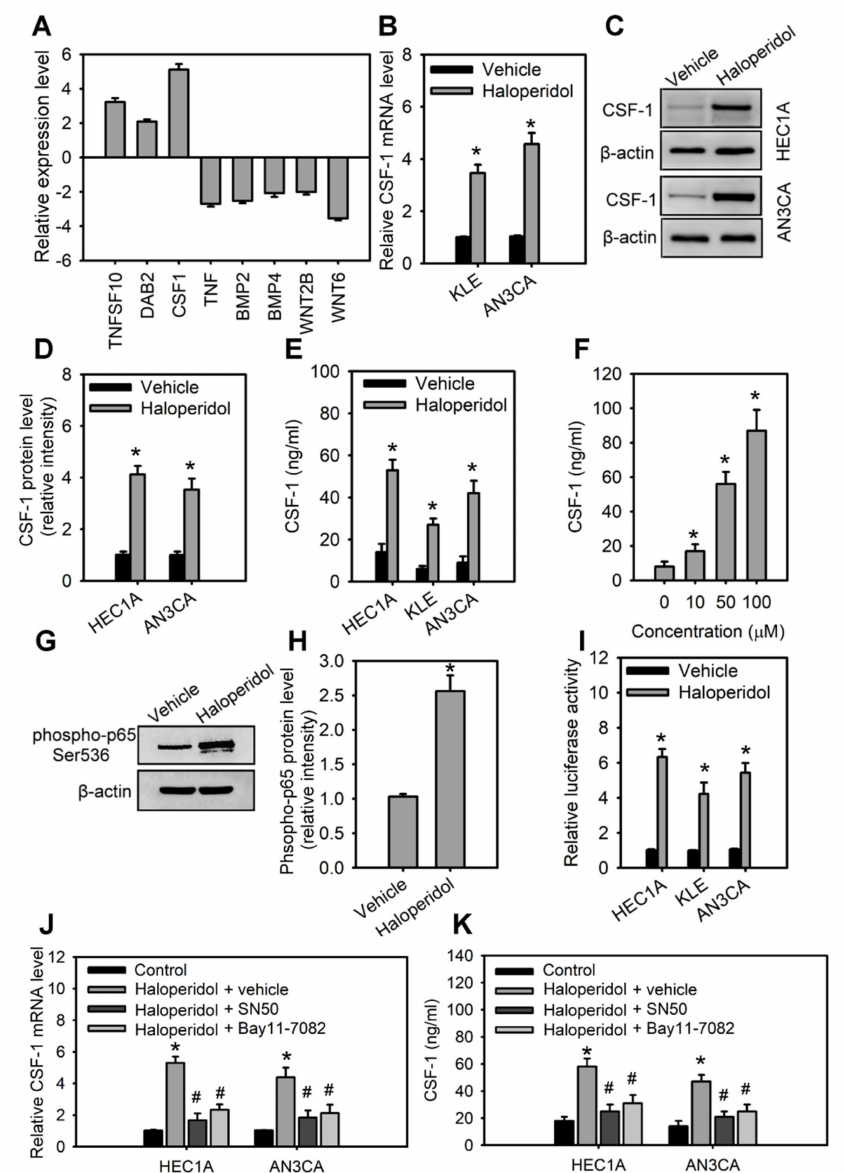
Figure 4. Haloperidol induces the production and secretion of CSF-1 in HECCs via NF- κ B activation. ( A ) The differentially expressed genes in HEC1A with at least a 2-fold change after 48 h treatment of 10 µ M haloperidol. The levels of expressions are measured with the RT 2 Profile PCR Array TM . The relative mRNA levels ( B ), protein levels ( C ), relative protein densities ( D ), and concentrations of CSF-1 in the medium ( E ) of HEC1A, AN3CA, and KLE cells receiving 10 µ M of haloperidol for 48 h. ( F ) Concentrations of secreted CSF-1 in the medium of HEC1A cells responded to 0, 10, 50, and 100 µ M of haloperidol for 48 h. ( G , H ) Western blot analysis and quantification for p65 phosphorylation in HEC1A cells treated with 10 µ M of haloperidol for 30 min. ( I ) NF- κ B signaling activities in HEC1A, AN3CA, and KLE cells with or without the treatment with 10 µ M of haloperidol for 48 h. The NF- κ B signaling activities were measured with luciferase reporter assays. The relative mRNA levels ( J ) and concentrations of CSF-1 (in the conditioned medium) ( K ) of HEC1A and AN3CA cells treated for 48 h with 10 µ M of haloperidol with or without the NF- κ B inhibitors (SN50, 50 µ g/mL; BAY 11-7082, 2.5 µ M). Data are presented as means ± SD within triplicate experiments. * p < 0.01, compared with the untreated or vehicle group (normal saline). # p < 0.01, compared with the haloperidol plus vehicle